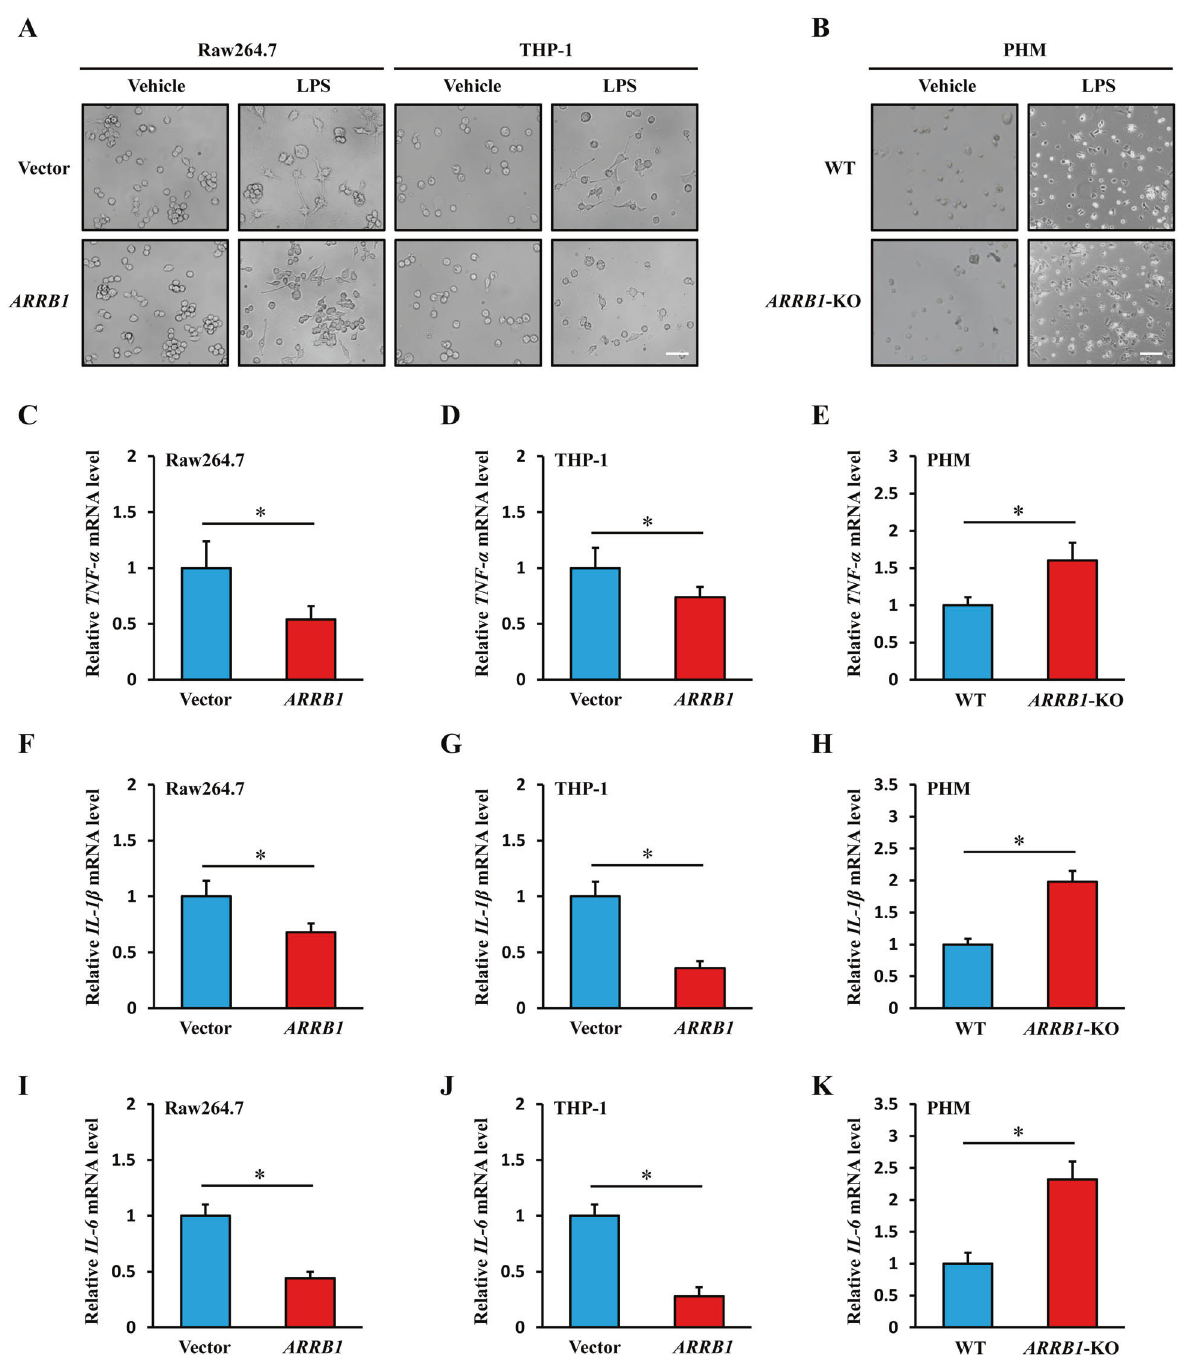
Fig. 4 ARRB1 suppressed the activation of hepatic macrophages induced by LPS. A Representative morphology images of vector- and ARRB1 -overexpressing Raw264.7 and THP-1 cells with LPS (1 μ g/ml) challenge for 6 h by an inverted microscope (scale bar: 50 μ m). B Representative morphology images of WT and ARRB1 -KO mouse primary hepatic macrophages with LPS (0.5 μ g/ml) were challenged for 6 h (scale bar: 50 μ m). C – K TNF- α , IL-1 β , and IL-6 mRNA levels in vector- and ARRB1 -overexpressing Raw264.7 and THP-1 cells with LPS (1 μ g/ml) challenge for 6 h and mouse primary hepatic macrophages with LPS (0.5 μ g/ml) challenge for 6 h were analyzed by real-time PCR. Data are presented as the mean ± SD of three separate experiments. * P < 0.05 by Student ’ s t